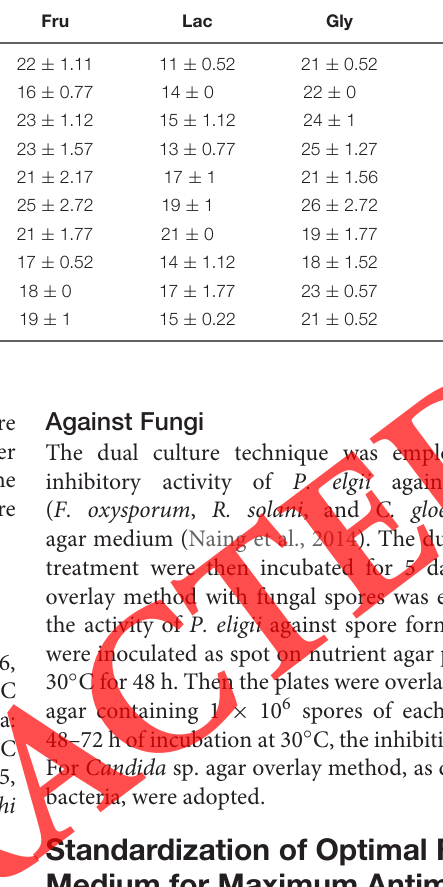
TABLE 3 | Antimicrobial activity of crude extract in TBS media supplemented with different carbon sources. Test